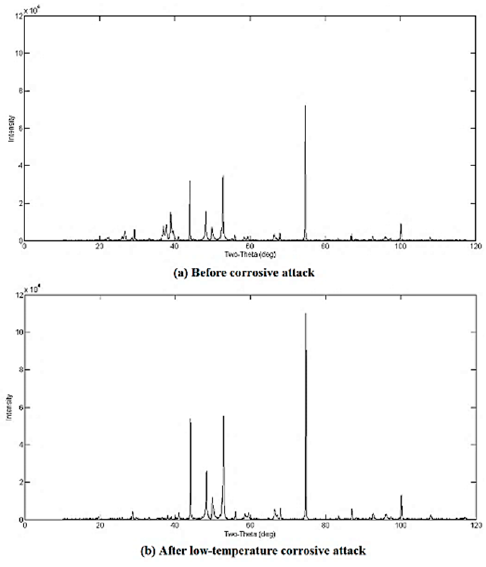
Figure A26. Qualitative XRD analysis of the surface of CS-B-BN ( a ) before corrosive attack, ( b ) after low-temperature corrosive attack.